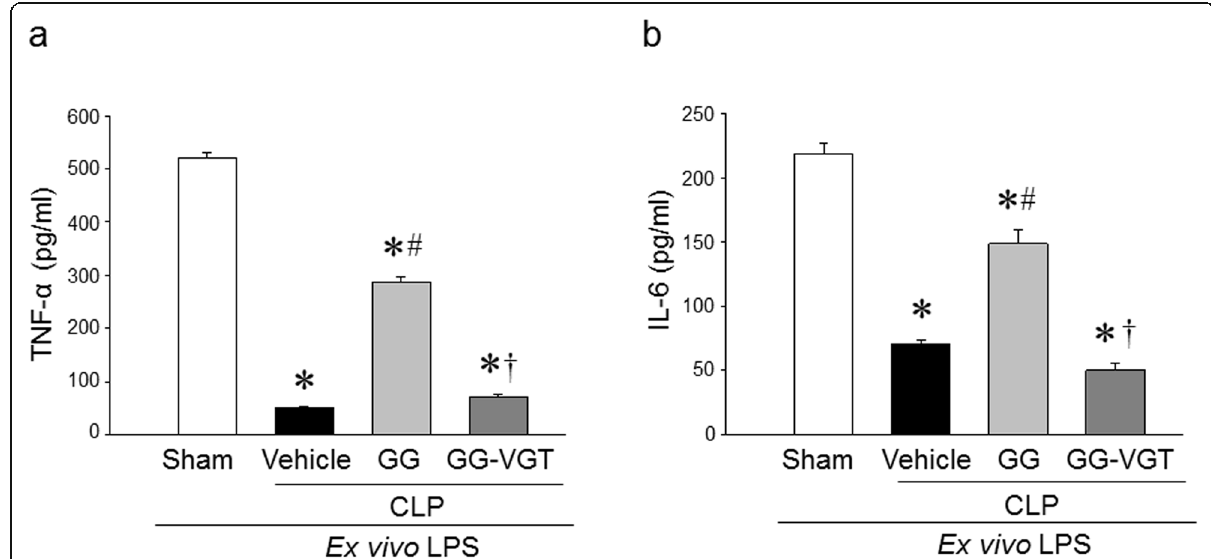
Fig. 2 Ghrelin and GH in combination restores immune response in aged septic rats. Rats were subjected to sham or CLP operation and treated with vehicle (normal saline) or GG (ghrelin 80 nmol/kg, GH 50 μ g/kg) at 5 h after CLP. In an additional group of rats, vagotomy was performed at the time of CLP and treated with GG at 5 h after CLP. Spleens were harvested at 20 h after CLP. Splenocytes were isolated and stimulated with LPS (100 ng/ml) for 5 h. The release of ( a ) TNF- α and ( b ) IL-6 in the medium were measured by ELISA. Data are expressed as mean ± SEM ( n = 4 – 5 rats/group). * P < 0.05 vs. sham; # P < 0.05 vs. CLP with vehicle treatment; † P < 0.05 vs. CLP with GG